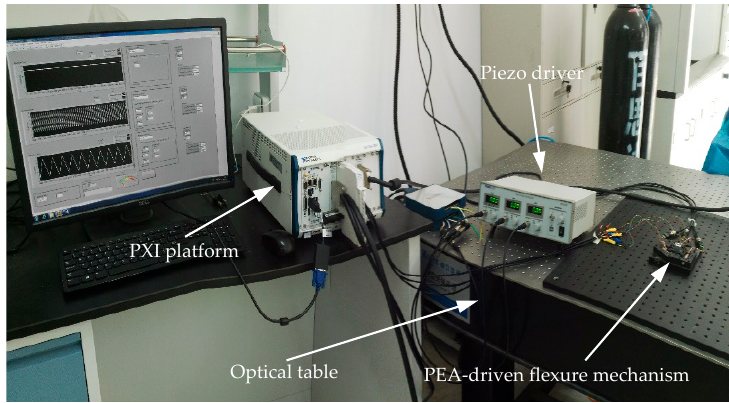
Figure 1. The experimental setup of the overall system.